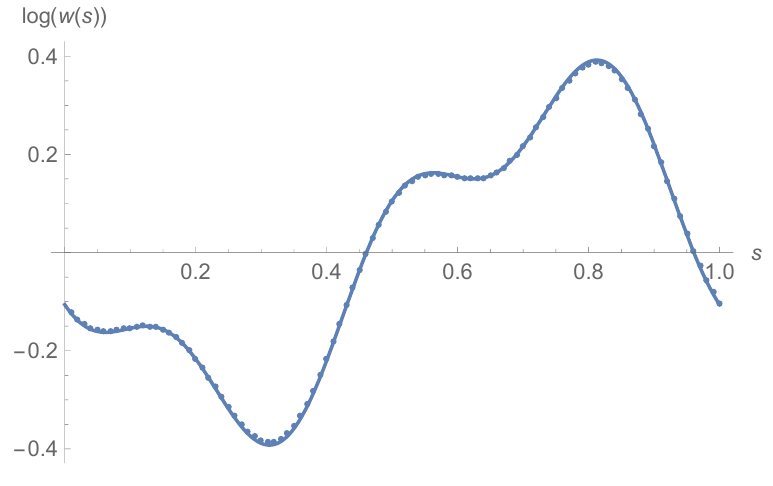
Figure 6 . The curve depicts log w ( s ) = − sin(2 πs ) tion (4.42) with the α -parameters given by (5.6). The dots represent the same quantity obtained from (5.1) with n = 100